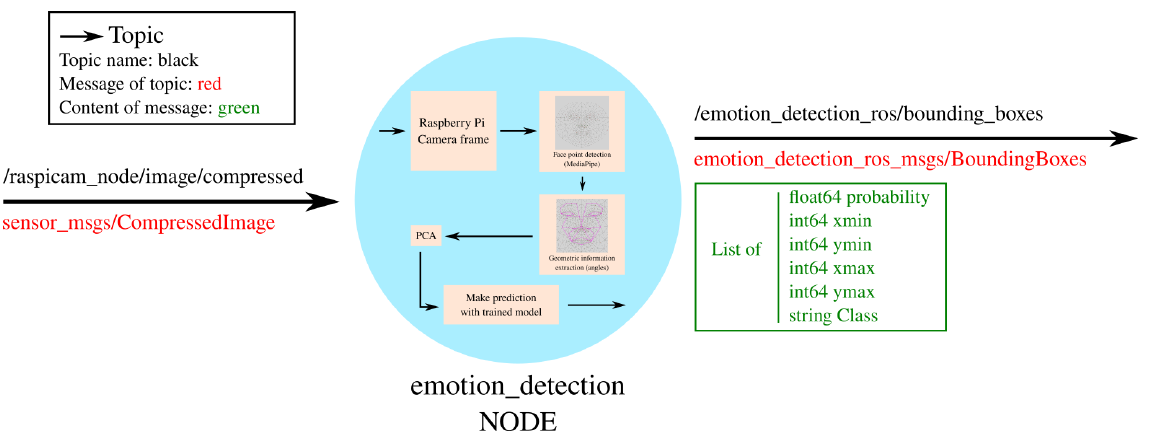
Figure 6. General scheme of the ROS